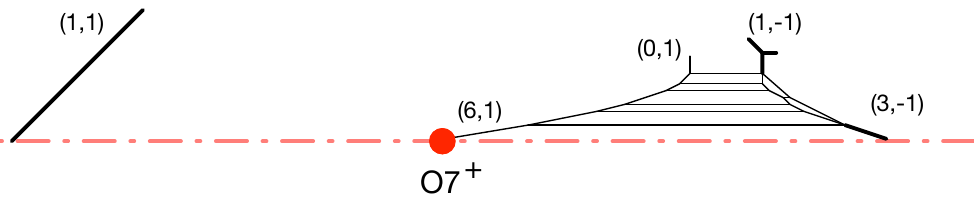
Figure 24 . A 5-brane con(cid:12)guration for the SU(6) 0 + 1